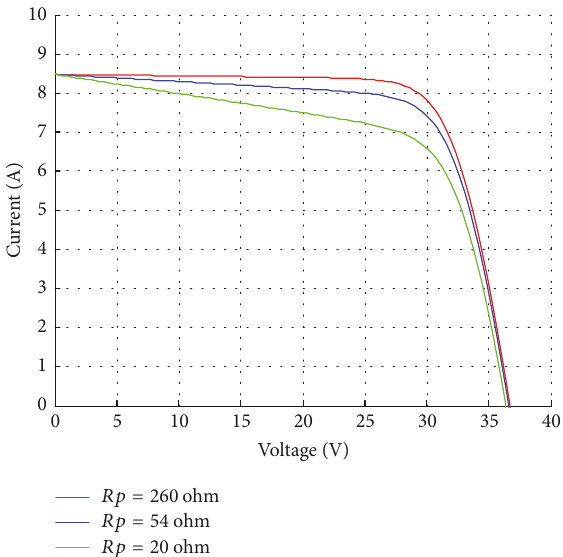
Figure 14: 𝐼 - 𝑉 curves for different 𝑅 p .